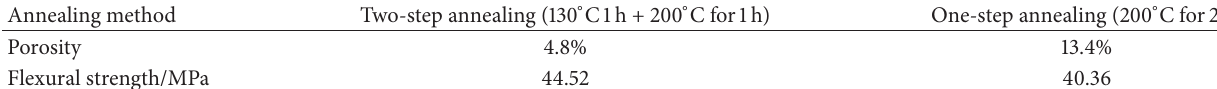
Table 2: Effect of annealing method on the porosity and flexural strength.